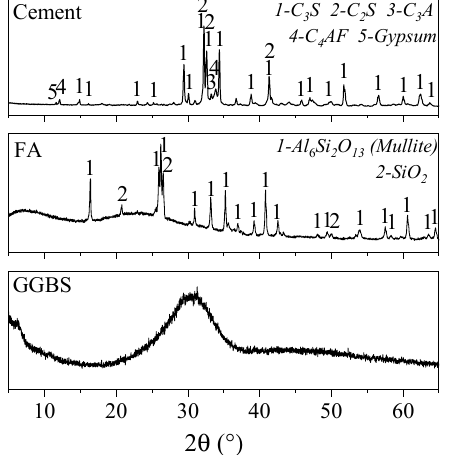
Figure 1. XRD patterns of cement, FA, and GGBS.